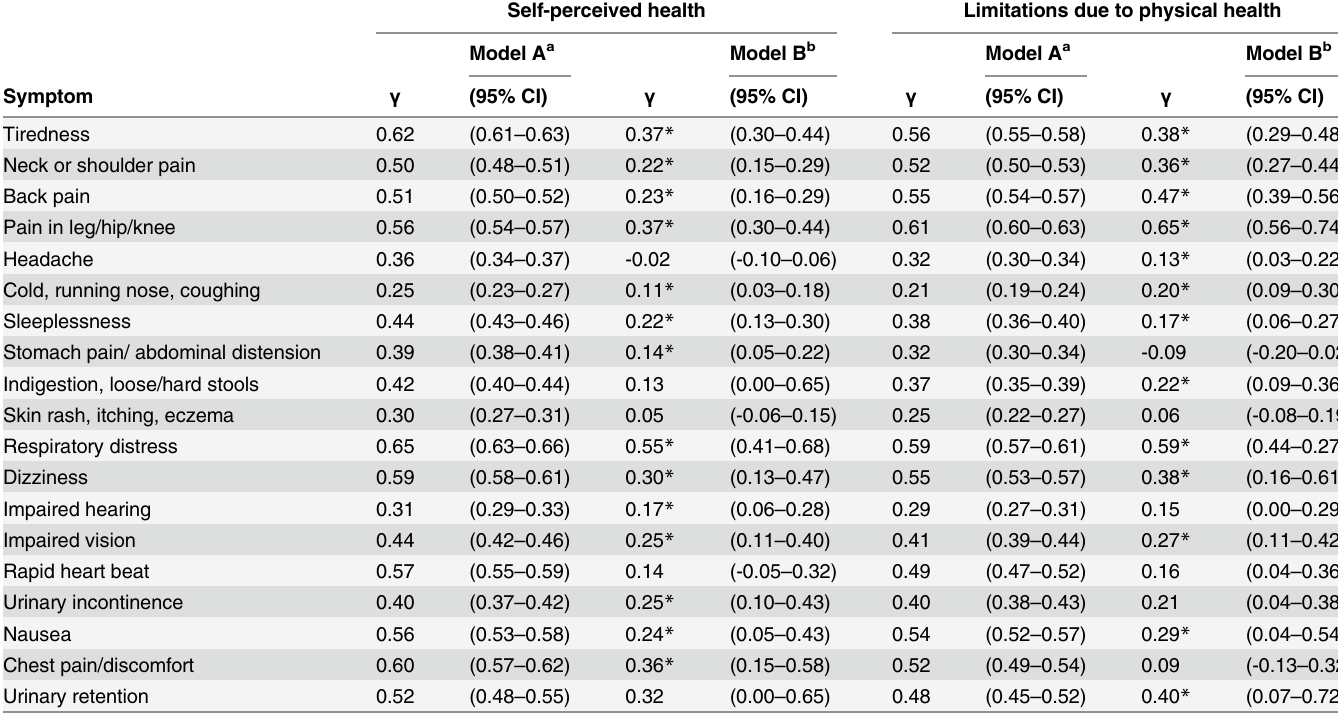
Table 2. Associations between 19 experienced somatic symptoms, self-perceived health and limitations due to physical health. N = 32,762 –